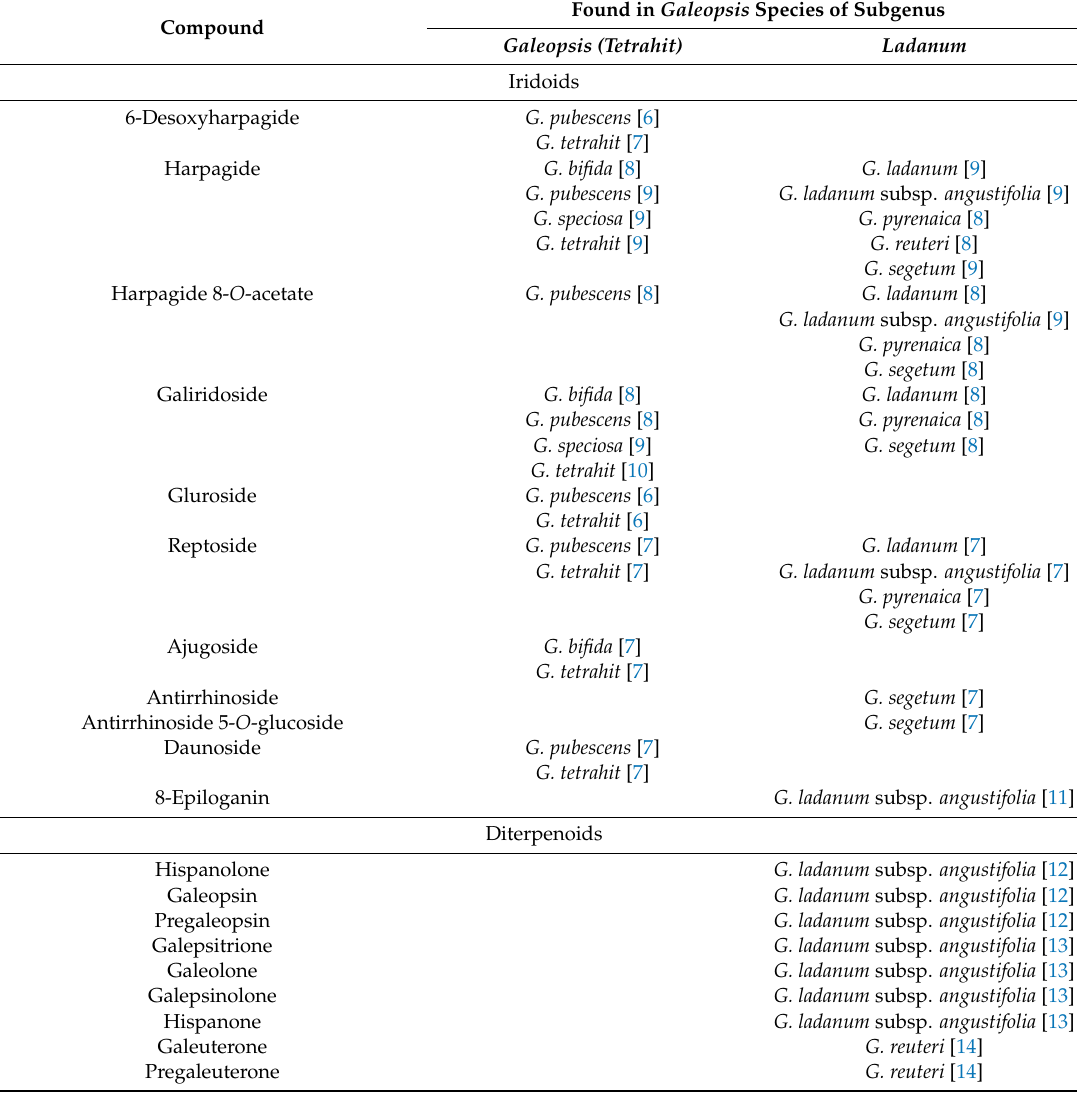
Table 1. Known compounds of Galeopsis genus (literature